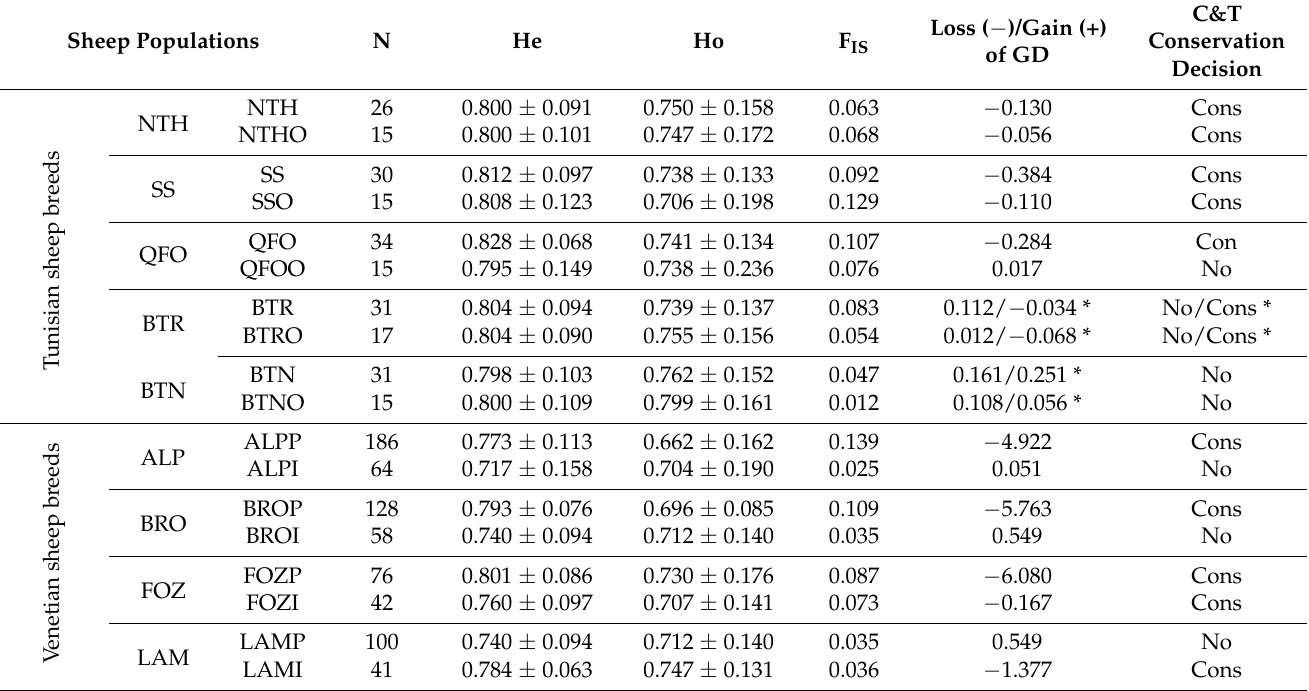
Table 4. Comparison of genetic diversity levels between private and public/institutional breeding systems and conservation decisions according to Caballero and Toro’s approach.